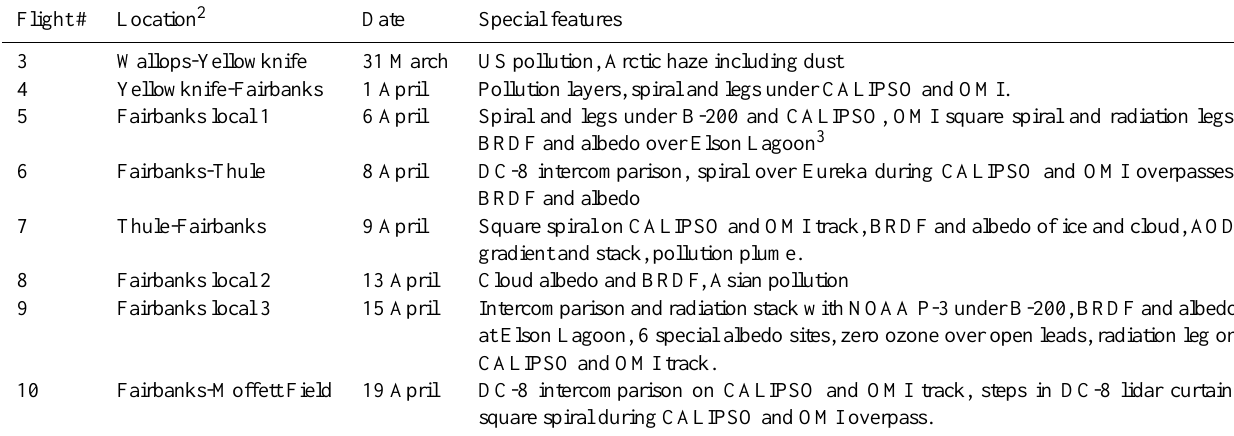
Table 4b. P-3 flights during the ARCTAS-A spring deployment 1